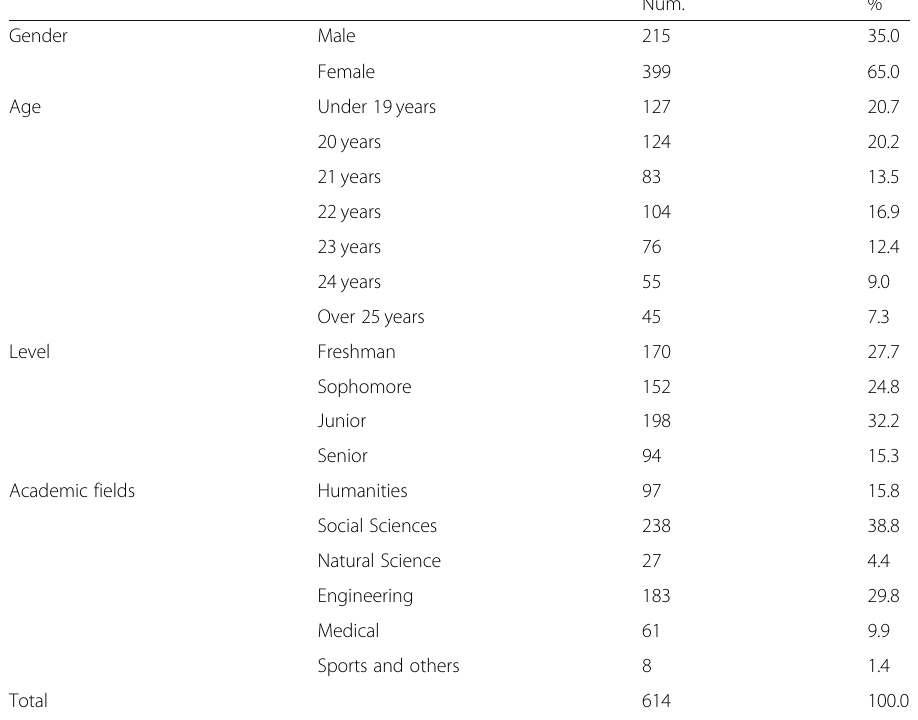
Table 1 Demographic characteristics